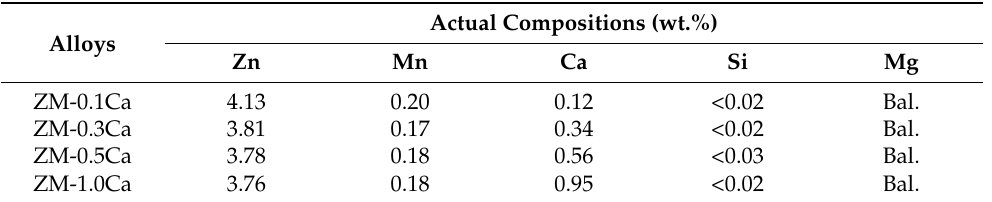
Actual Compositions